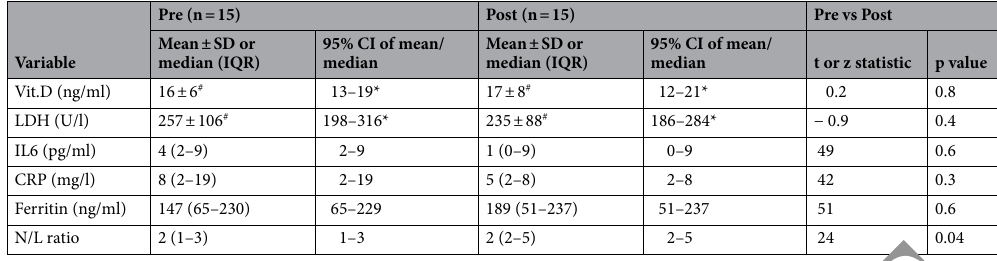
Table 5. Values of various parameters analysed in the eNVD sub group before and after treatment. Vit.D Vitamin D, CRP C-reactive protein, LDH Lactate dehydrogenase, Il-6 Interleukin-6, N/L ratio Neutrophil/